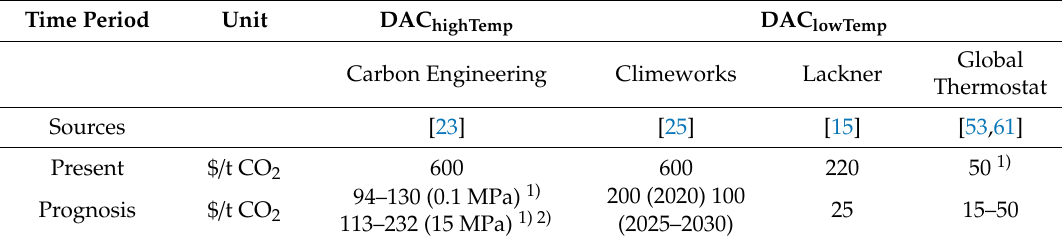
Table 6. Costs of various types of Direct Air Capture (DAC)